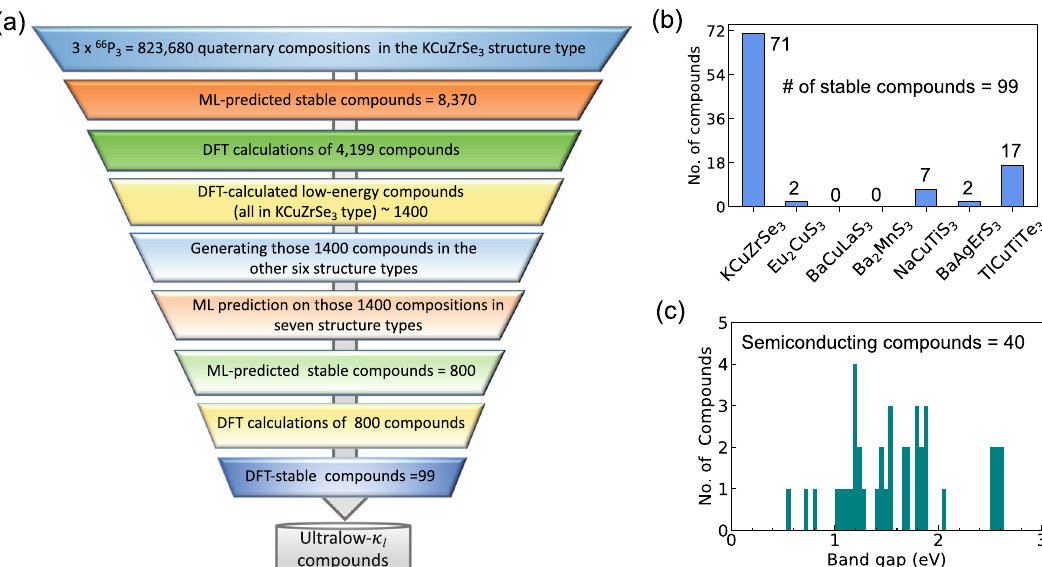
Fig. 3 Machine-learning assisted discovery of novel materials. a Schematic work fl ow of novel materials ’ discovery with iterative use of the machine-learning (ML) method and density-functional theory (DFT) calculations. The stable and metastable compounds are de fi ned by their hull distance of (E hd ) = 0 and 0 < E hd ≤ 50 meV/atom, respectively. b The distribution of predicted stable compounds into seven structure types. c Histogram plot showing the distribution of the bandgaps of the predicted stable quaternary